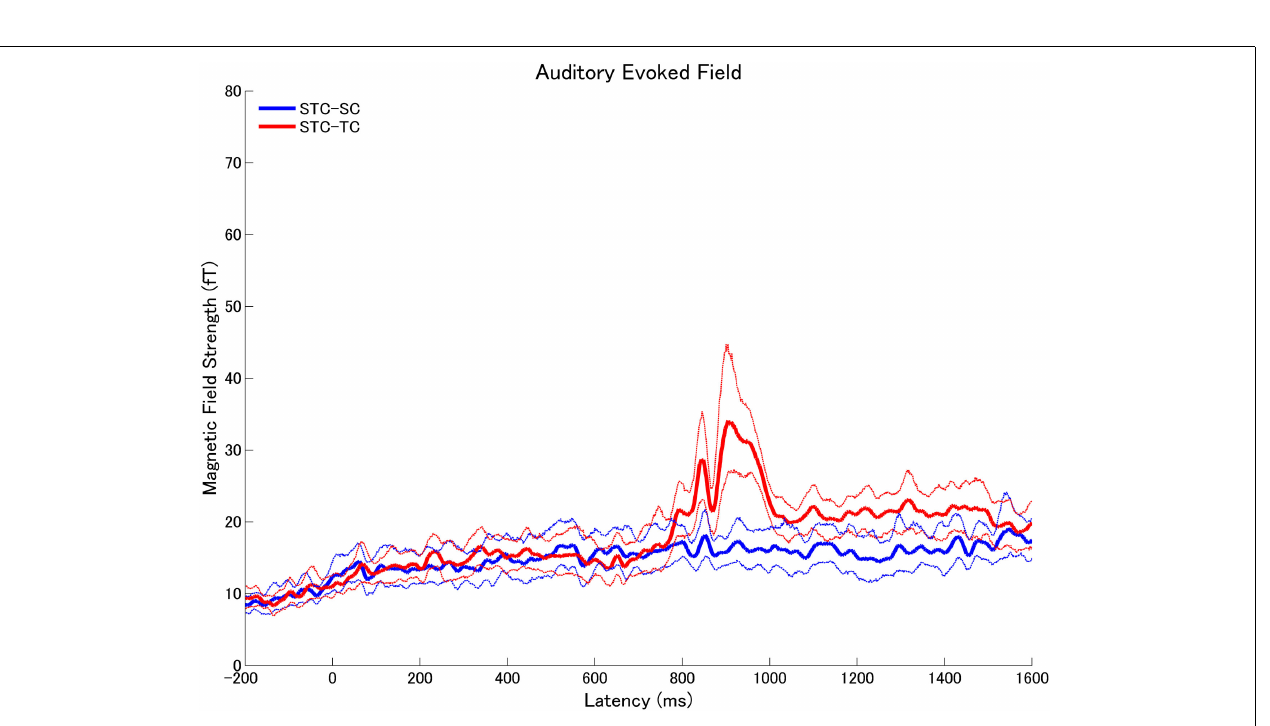
FIGURE 10 |The means and the 95% confidence interval limits of the root-mean-square (RMS) values of the subtracted magnetic fields (STC – SC: blue, STC –TC: red) across all subjects in experiment 2.